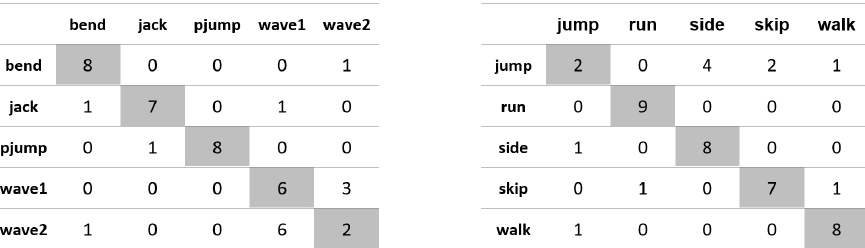
Figure A26. Confusion matrices for the experiment using the ‘upper-occlusion’ database, shorterMBR and Euclidean distance.